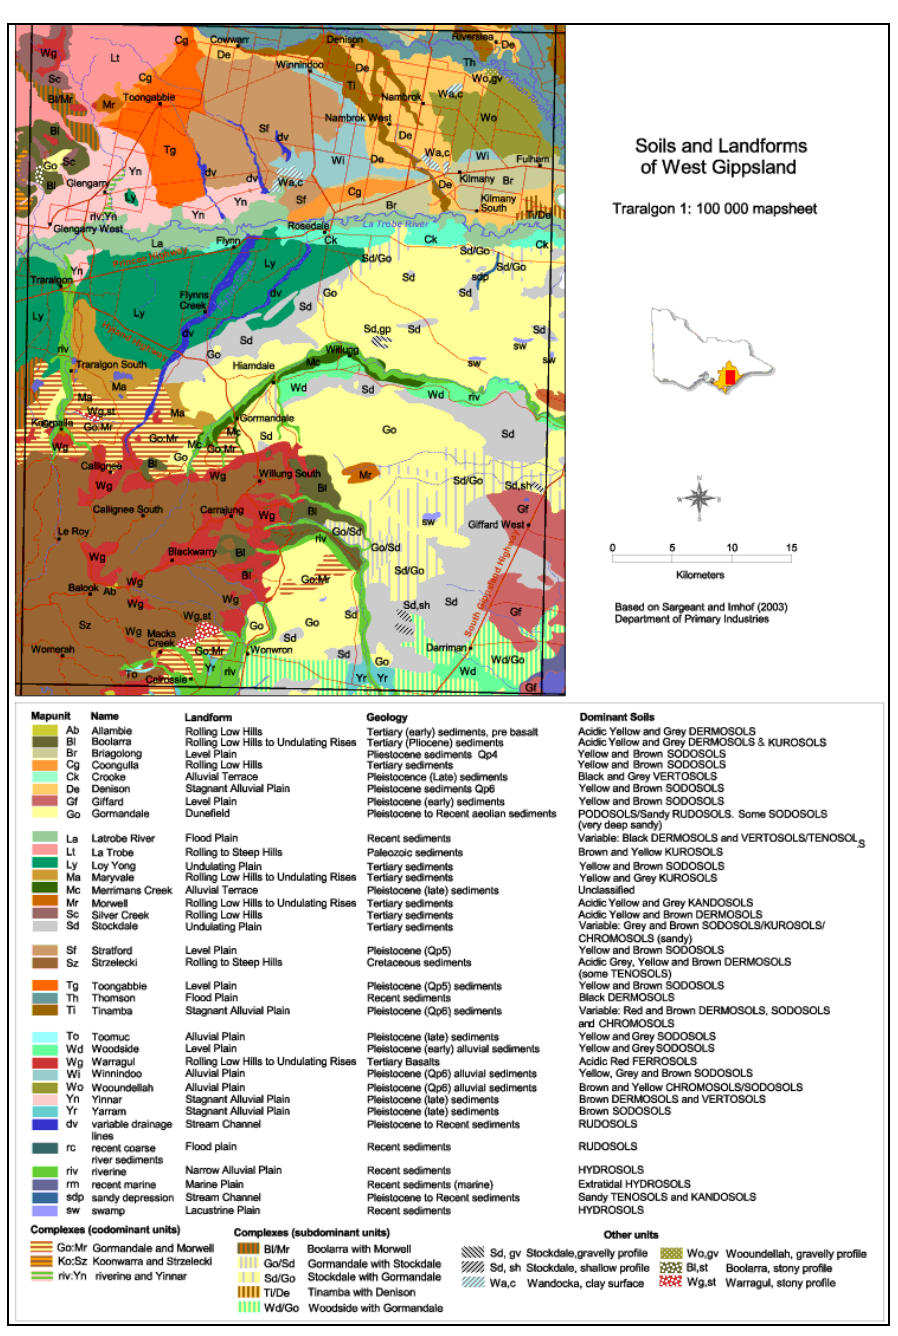
Figure 9. Example of 1:100,000 map sheet depicting soil/landform mapping. The map legend summarises the major landforms, geology and dominant soils for each unit and is clickable to access map unit descriptions.  State of Victoria, Department of Primary Industries 1997 Reproduced with